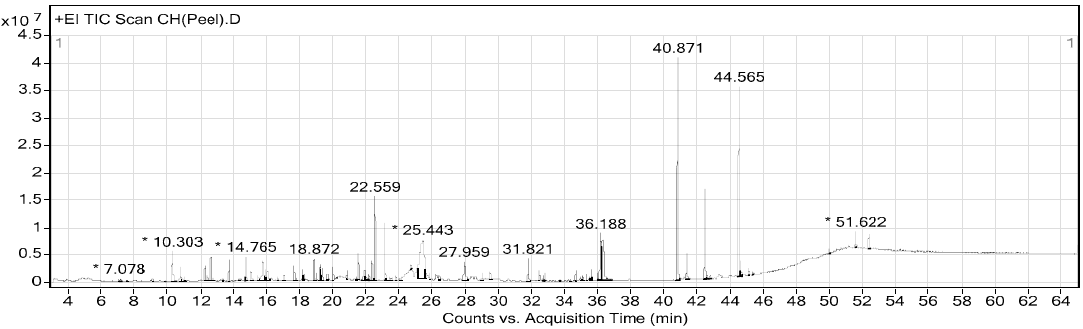
Figure 1. Gas chromatograph–mass spectrometer (GC-MS) chromatogram of Citrus hystrix peels (CHP). * Peaks of proposed phytochemical constituents in CHP were suggested by GC-MS.